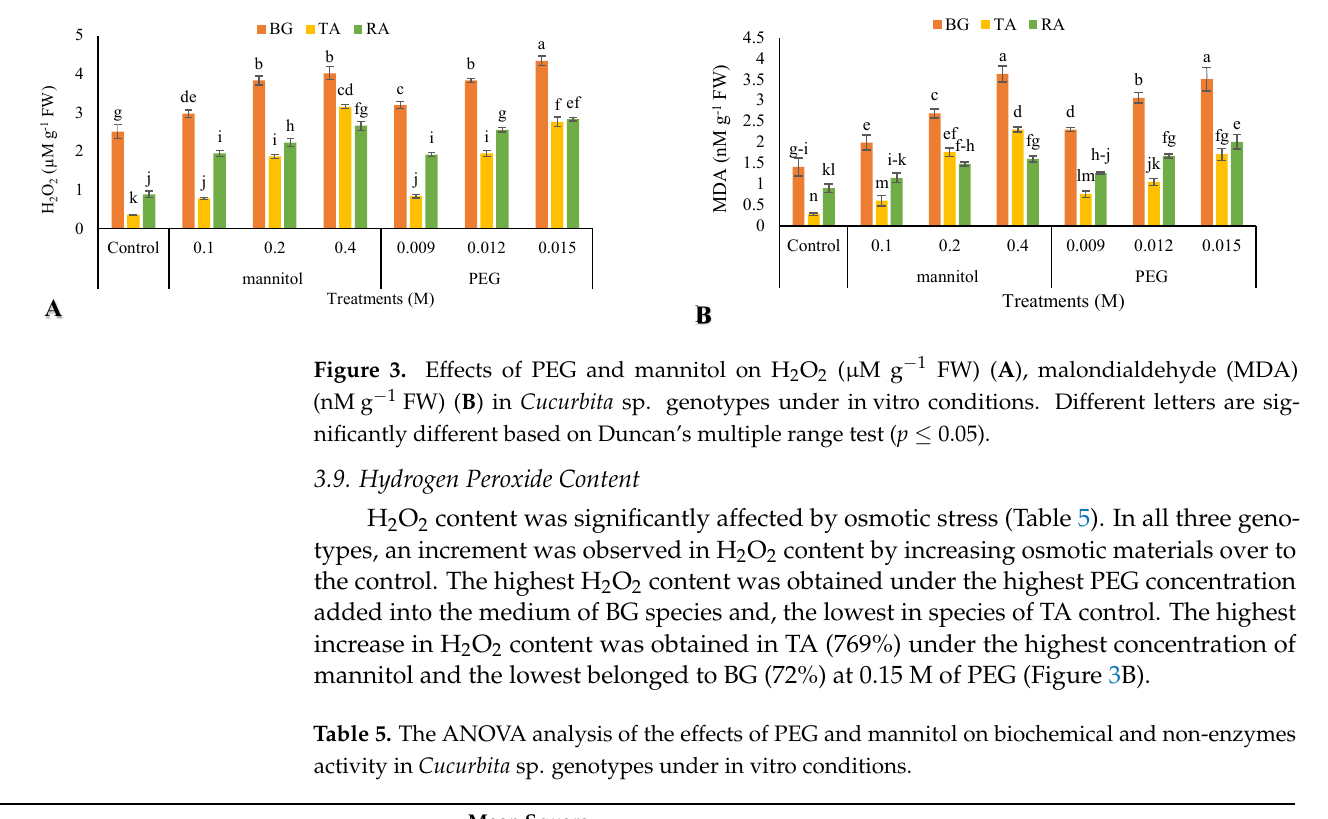
Table 4. The ANOVA analysis of the effects of PEG and mannitol on enzyme activity in Cucurbita sp. genotypes under in vitro conditions.